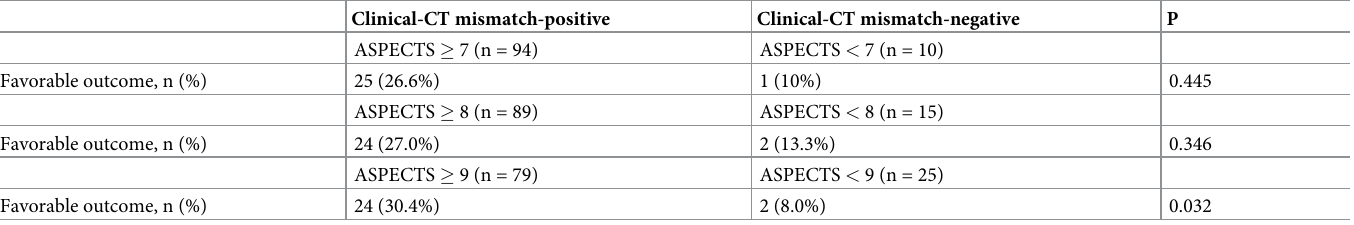
Table 3. Favorable outcome (modified Rankin scale � 1) at 3 months: Dichotomizing ASPECTS scores into clinical-CT Mismatch-positive or clinical-CT Mis- match-negative based on a score of � 7 versus < 7; � 8 versus < 8; and � 9 versus < 9.